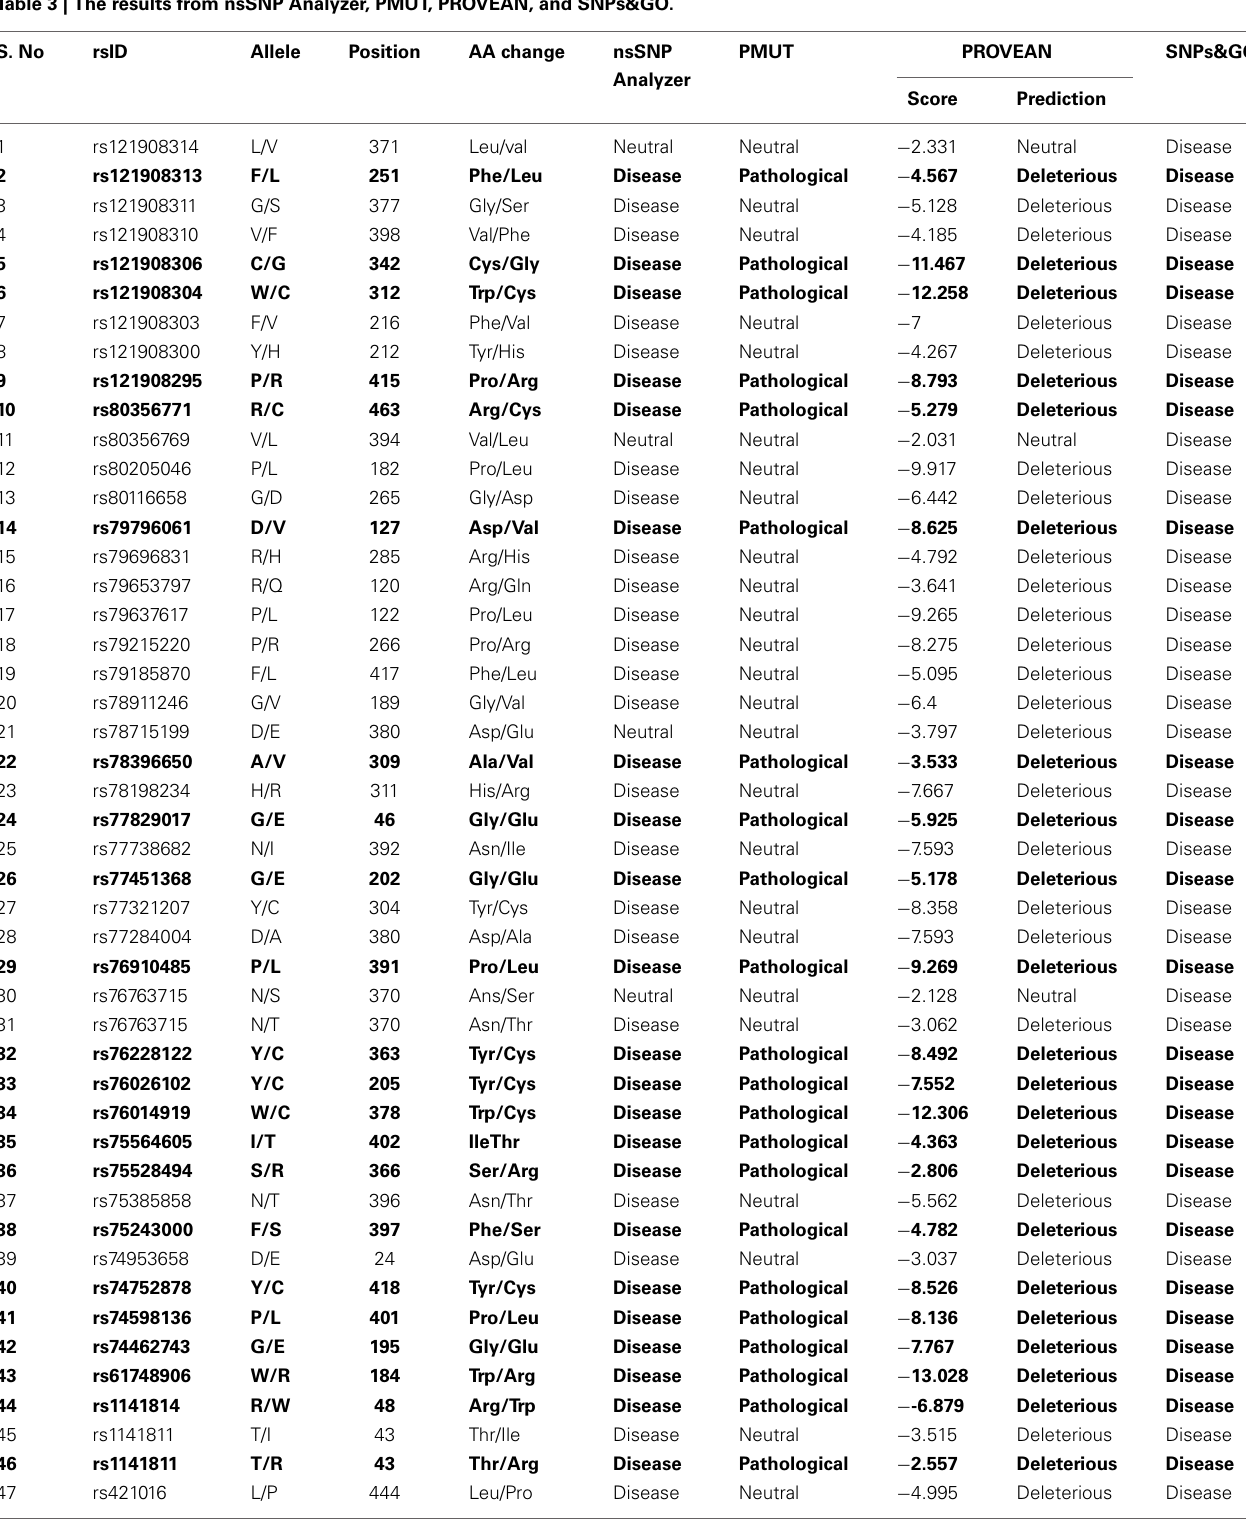
Table 3 | The results from nsSNP Analyzer, PMUT, PROVEAN, and SNPs&GO. S.